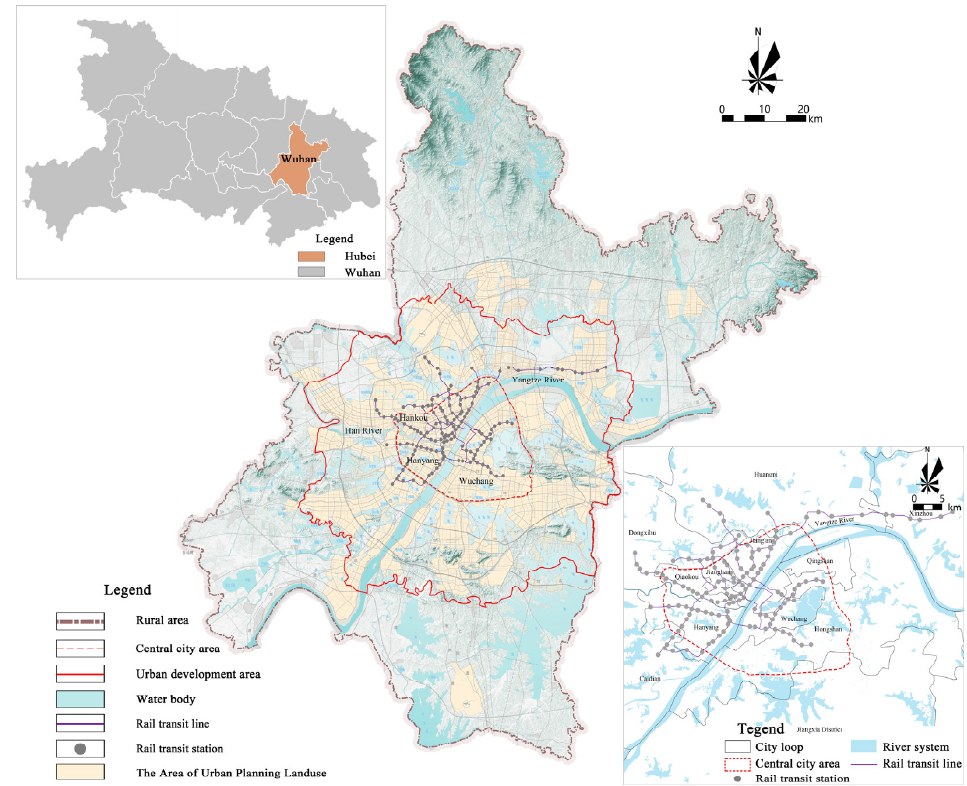
Figure 2. Location map of Wuhan.